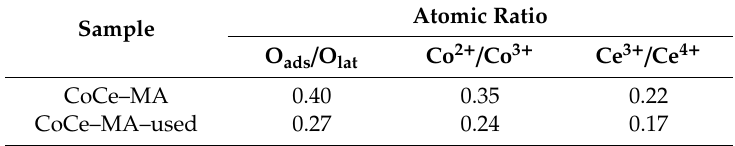
Figure 10. The relationship between T 90 (90% toluene conversion temperatures) and surface Co 2 + / Co 3 + , Ce 3 + / Ce 4 + ratios. Table 6. Surface atomic ratios of the CoCe–MA catalyst before and after reaction.